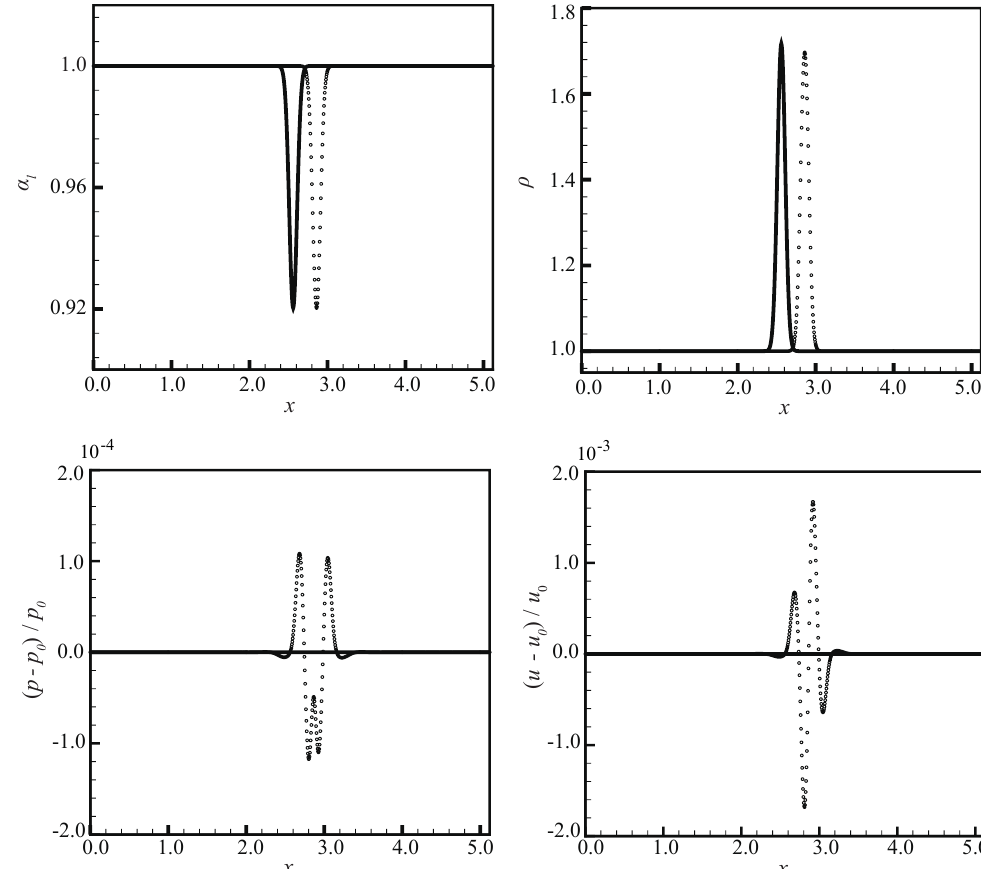
Figure 4. 1D bubble advection: The solid line represents the initial fluid condition, and ◦ represents the results when the Lagrangian bubble reaches x = 2.86 at t =